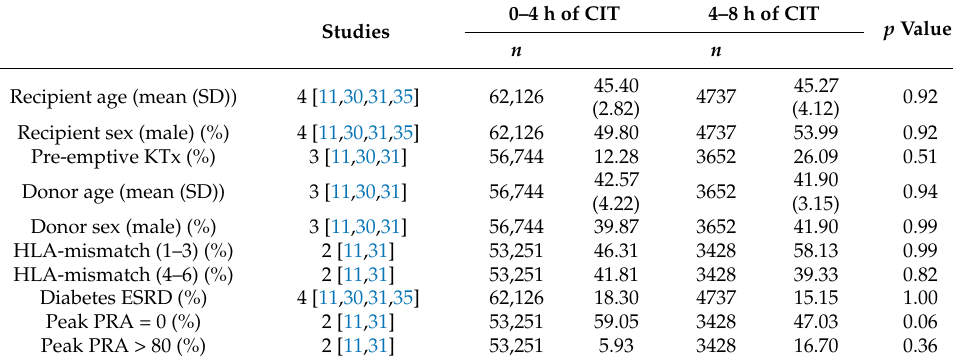
Table 2. Baseline characteristics of patients included in